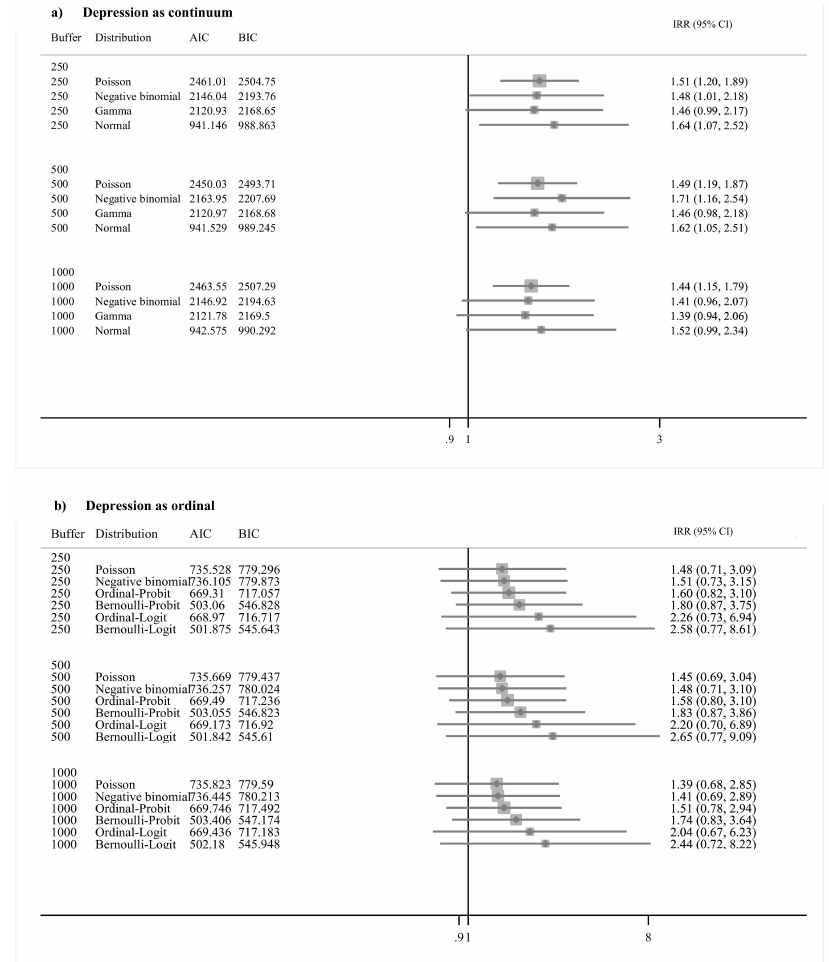
Figure 2. Direct association between depression ( a ) continuum and ( b ) ordinal variable and grayness summarized at bu ff er sizes of 250 m, 500 m, and 1000 m. Note: Bu ff er indicates distances in